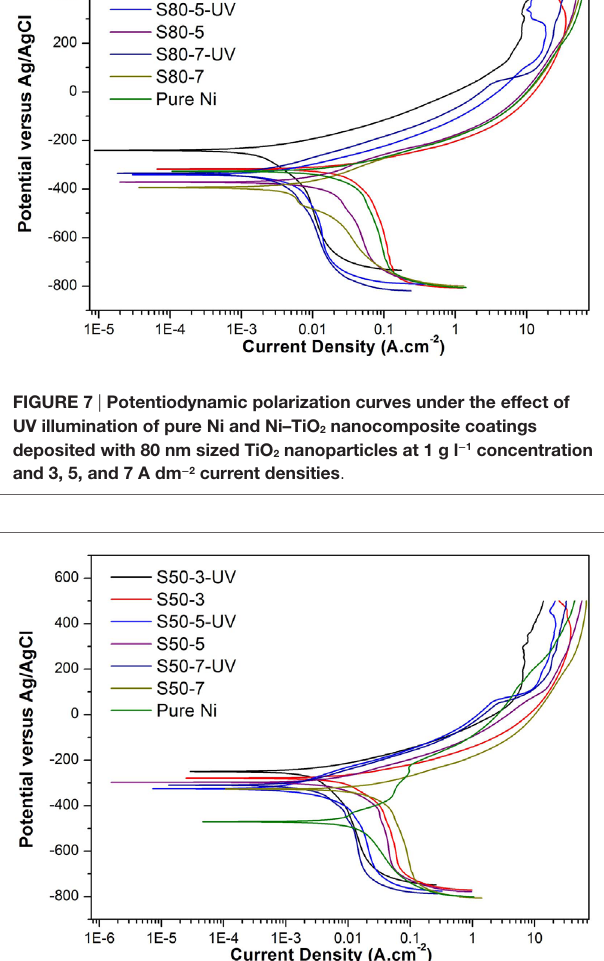
FigUre 8 | Potentiodynamic polarization curves under the effect of UV illumination of pure ni and ni–TiO 2 nanocomposite coatings deposited with 50 nm sized TiO 2 nanoparticles at 1 g l − 1 concentration and 3, 5, and 7 a dm − 2 current densities